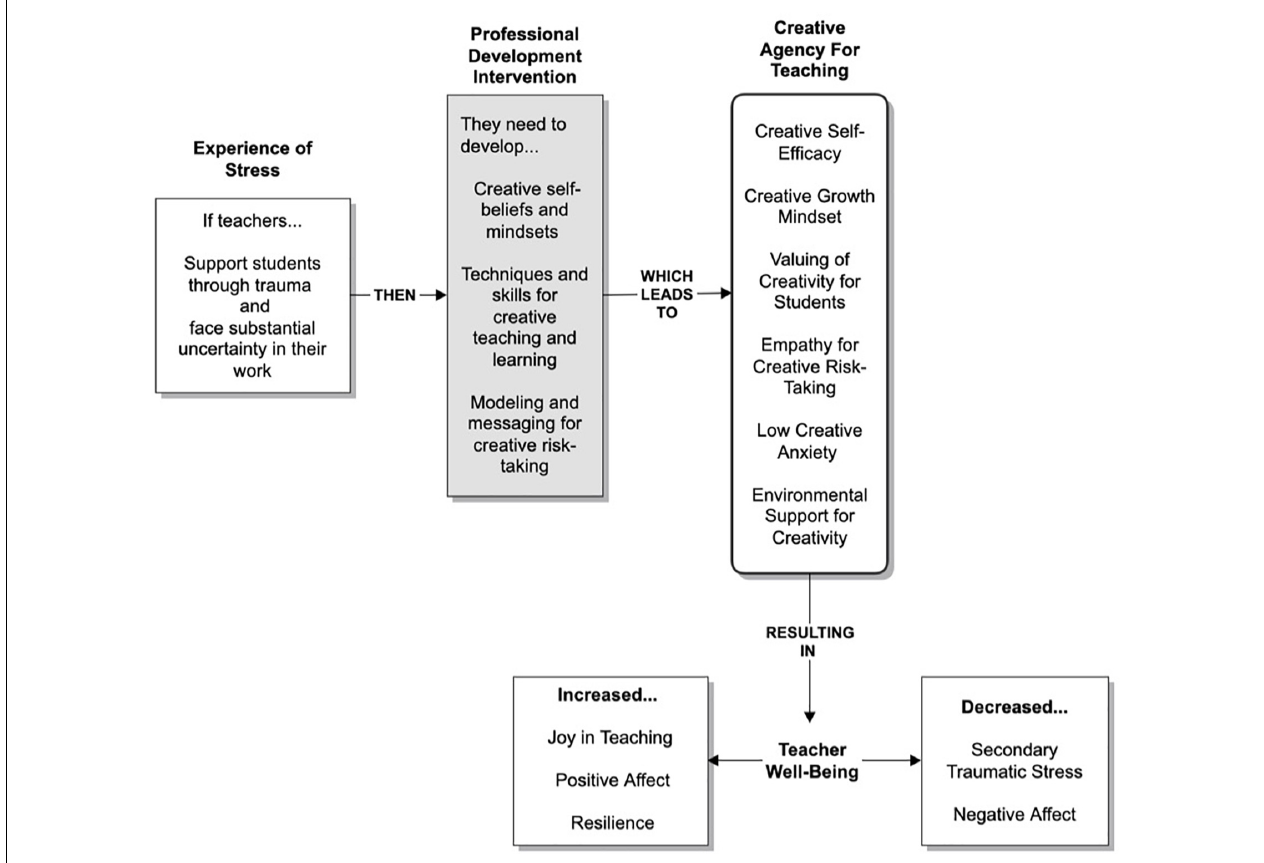
FIGURE 1 | Theoretical framework connecting teacher professional development to the cultivation of creative agency for teaching and teacher